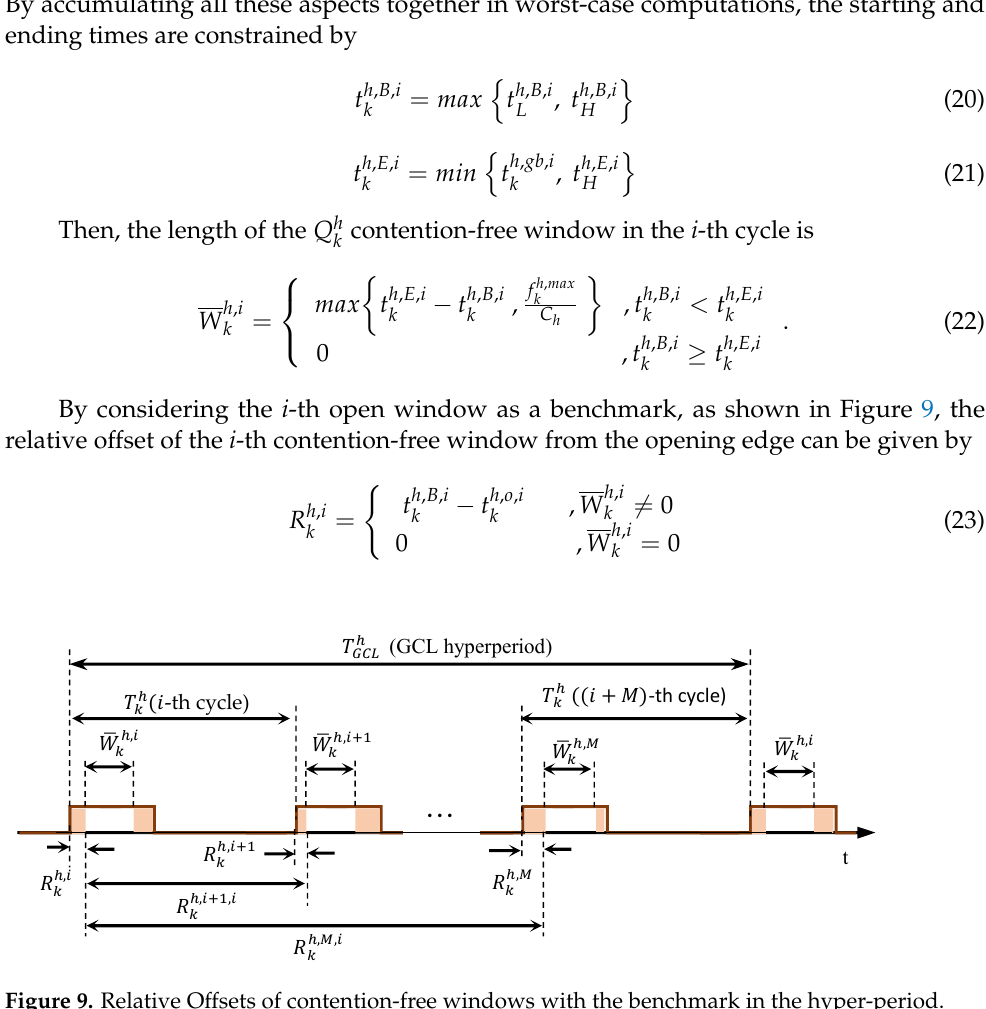
Figure 9. Relative Offsets of contention-free windows with the benchmark in the Figure 9 . Relative Offsets of contention-free windows with the benchmark in the hyper-period.